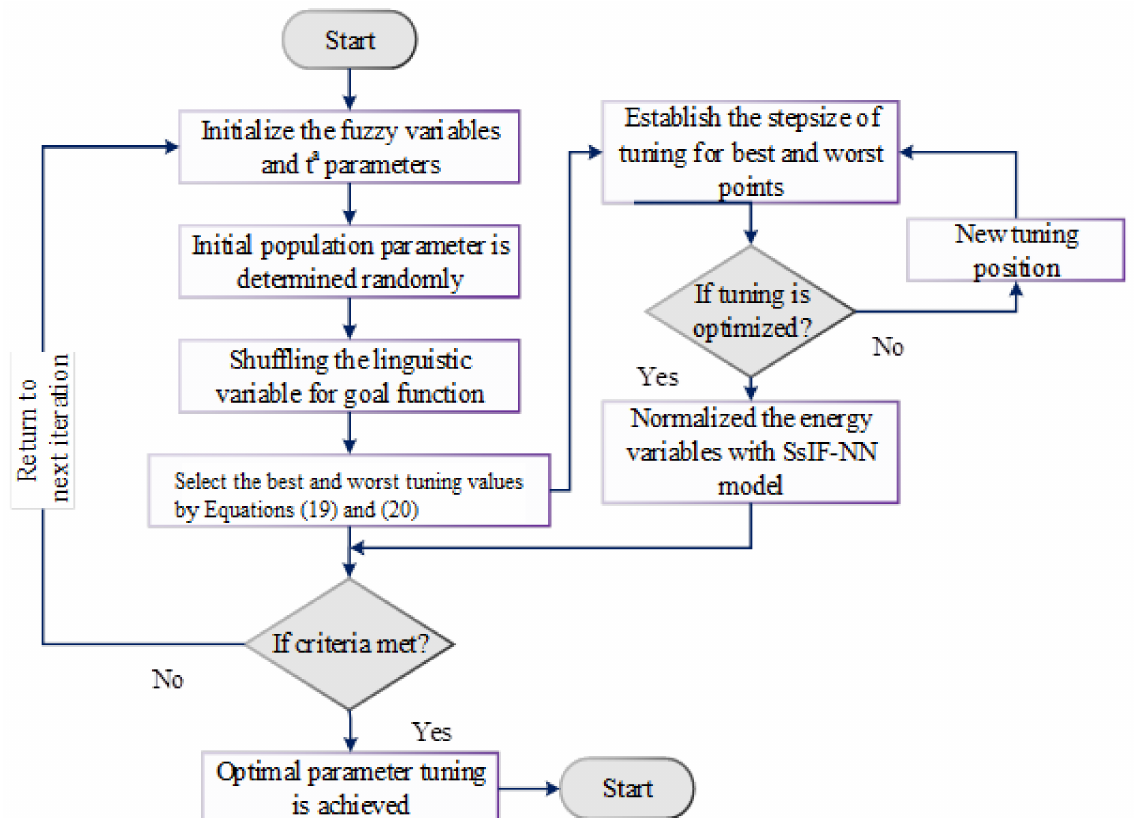
Figure 3. The flowchart of the proposed SSRD for SsIF-NN parameter